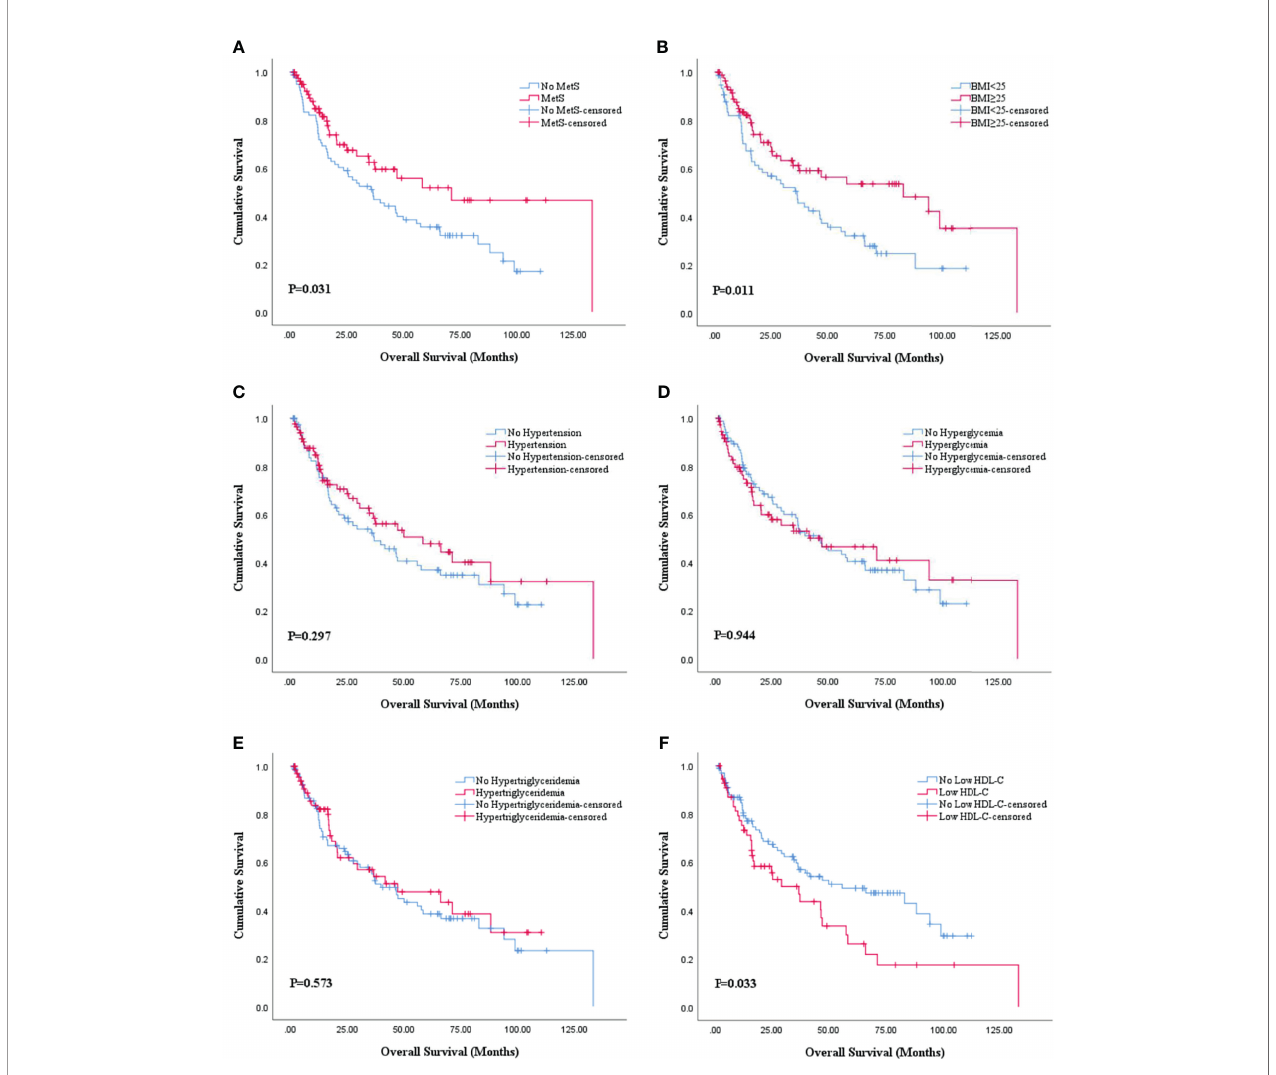
FIGURE 2 | Kaplan-Meier survival analysis of OS strati fi ed by MetS and its components after PSM. (A) MetS and non-MetS; (B) BMI <25 and BMI ≥ 25; (C) hypertension and no hypertension; (D) hyperglycemia and no hyperglycemia; (E) hypertriglyceridemia and no hypertriglyceridemia; (F) low HDL-C and no low HDL-C. BMI, body mass index; HDL-C, high density lipoprotein cholesterol; MetS, metabolic syndrome; OS, overall survival; PSM, propensity score